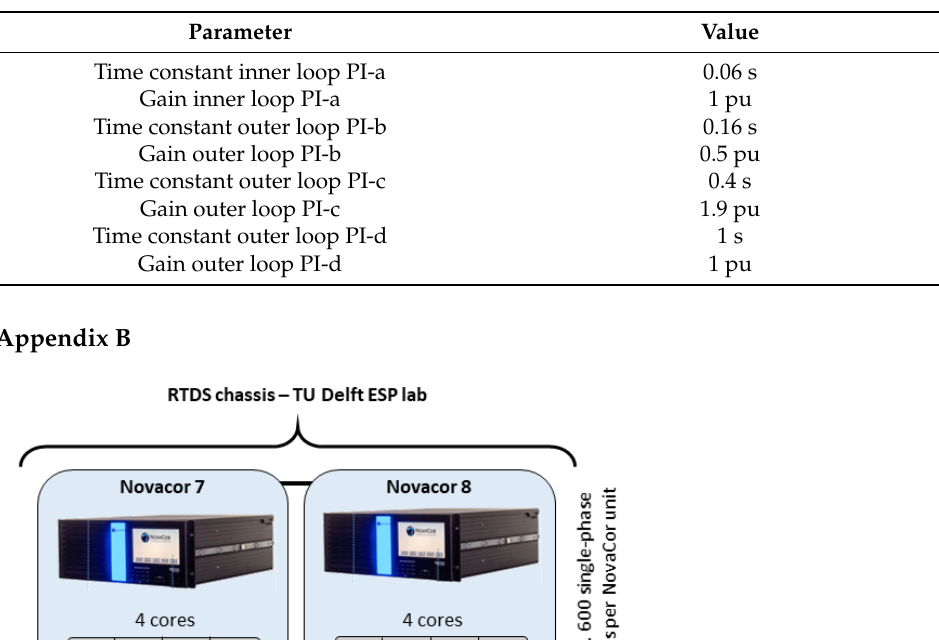
Table A2. Values of the time constants and gains used in the PI controller of the buck converter in Scenario 2.